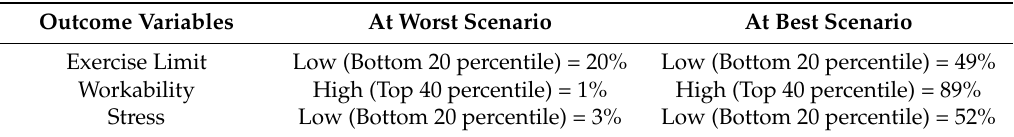
Table 2. Probabilities at the Simulated Worst and Best